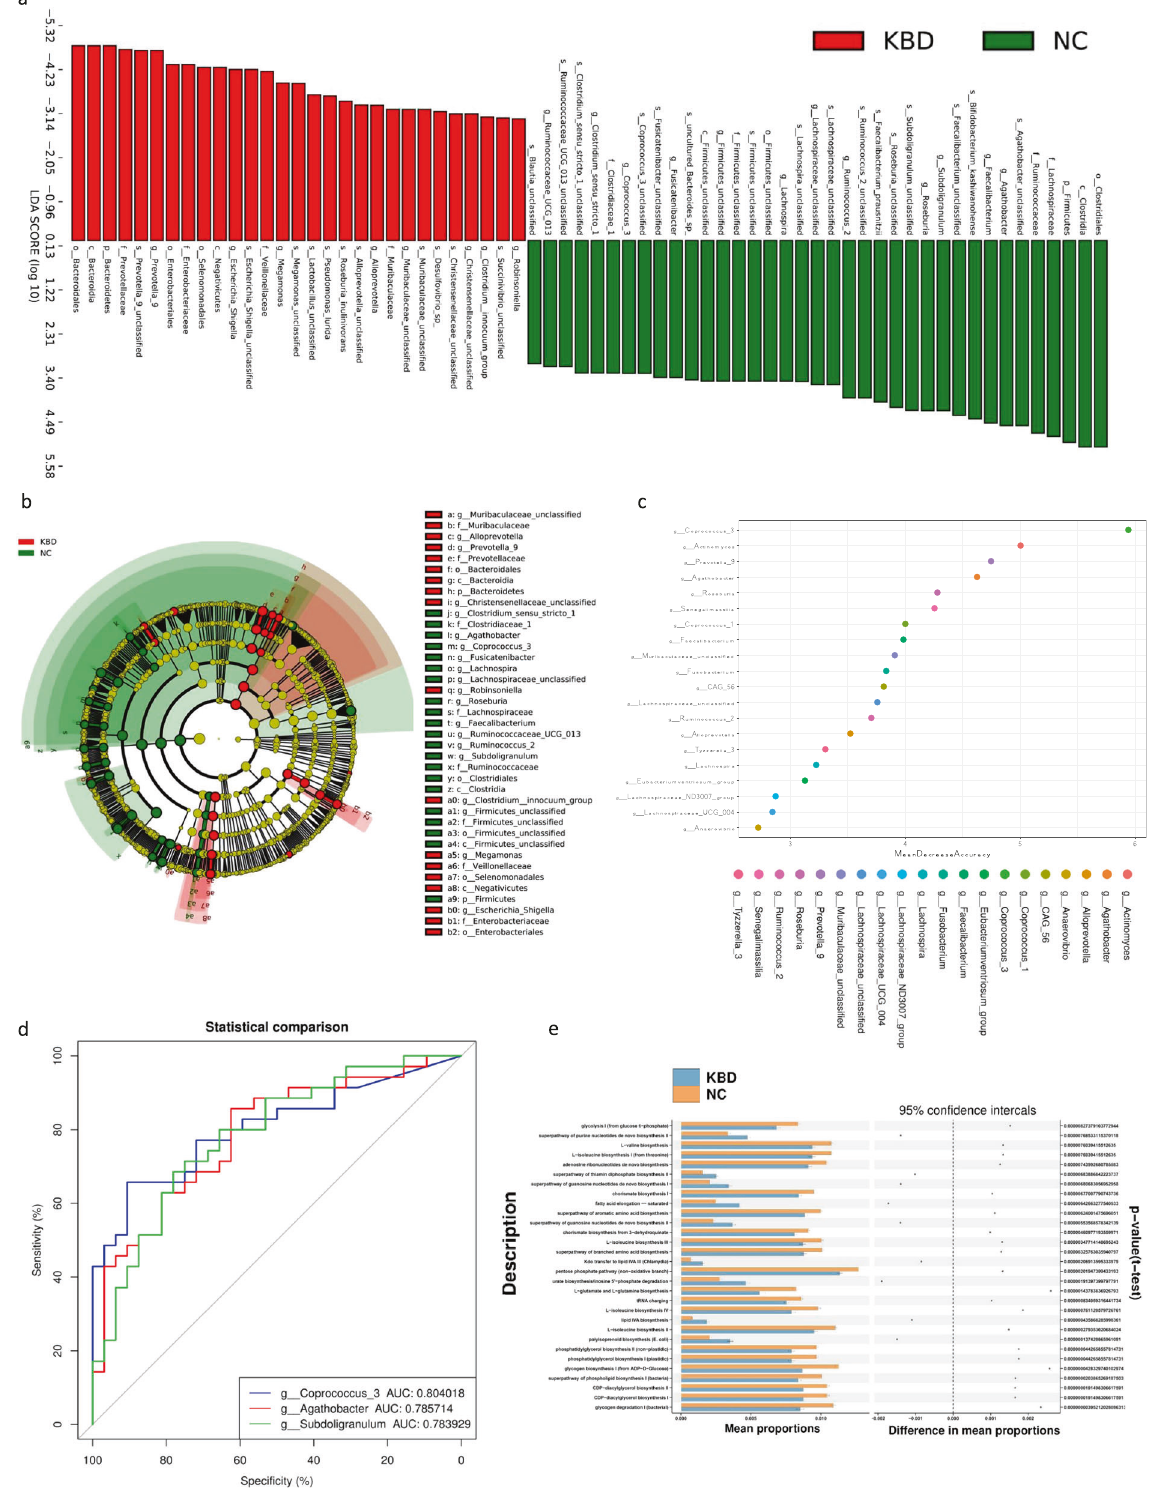
Fig. 2 Gut microbiome differential and functional analysis. a Linear discriminant analysis (LDA) integrated with effect size (LEfSe). The differences in abundance between the KBD and NC group. b Cladogram indicating the phylogenetic distribution of microbiota correlated with the KBD and NC group. c Classi fi cation performance of a random forest model using 16s rRNA genus abundance assessed by R random Forest package. d ROC curve displaying the top 3 biomarkers for classi fi cation between KBD and NC. AUC, area under curve. e Predicted function of gut microbiota based on KEGG pathway analysis. The extended error bar plot showed the signi fi cantly different KEGG pathways between KBD and NC group.